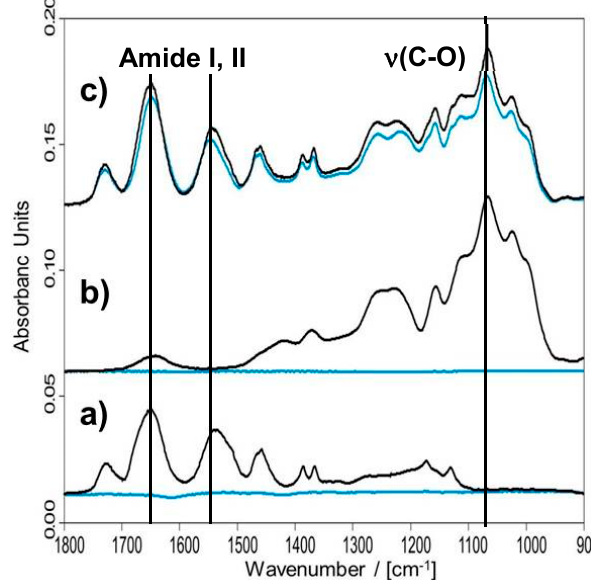
Figure 3. Transmission FTIR spectra of casted films of PNIPAM-DMAEMA ( a ), CS ( b ) and PNIPAM-DMAEMA/CS-1.2 ( c ) at Ge/GeO x H y in the initial dry state (black) and the dry state after rinsing in HEPES buffer at pH = 7.0 (blue), respectively.